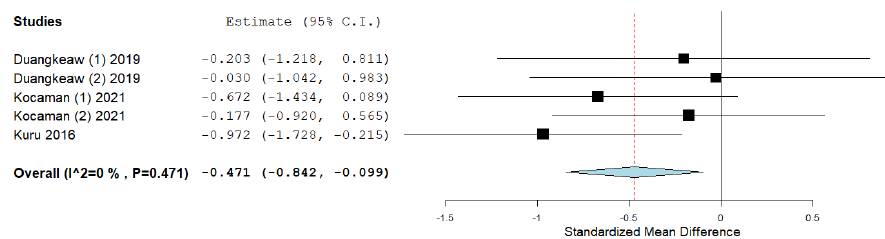
Figure 6. Effect size for the outcome ATR.